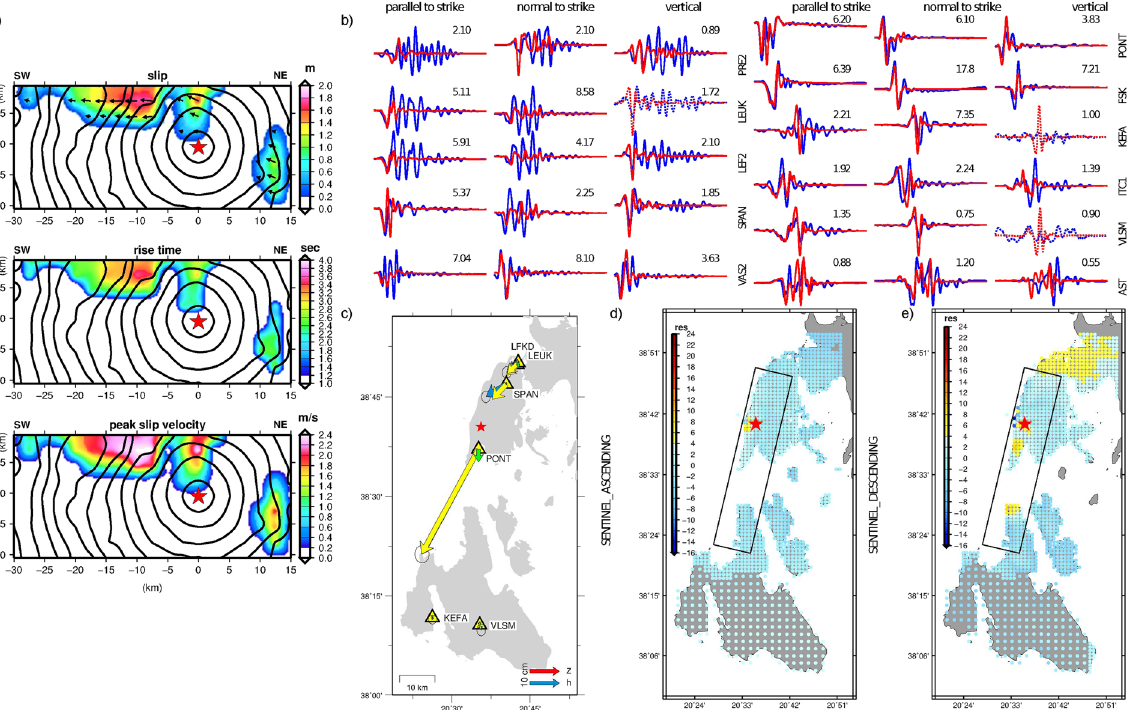
Figure 3. Kinematic rupture model and fit to the data. ( a ) Inverted rupture model of the 2015 Lefkada earthquake. Top, centre and bottom panels display slip, rise time and peak slip velocity, respectively. Black contours yield the rupture time every 1 s; rake angle is shown by black arrows in top panel; (b) comparison of recorded Strong Motion and HRGPS (in terms of ground velocities, blue lines) with synthetic waveforms (red lines). Dashed lines show predicted time series not included during the inversion. Peak amplitudes (cm * s − 1 ) of the observed waveforms are given by numbers; ( c ) measured and synthetic horizontal (blue and yellow arrows, respectively) and vertical (red and green arrows, respectively) co-seismic static displacements; ( d ) residuals between the observed and synthetic InSAR displacements, observed from ascending track Sentinel1-A; ( e ) residuals between the observed and synthetic InSAR displacements, observed from descending track Sentinel1-A. The plot was created using the GMT (Generic Mapping Tools, http://gmt.soest.hawaii.edu/) software package 57 , version